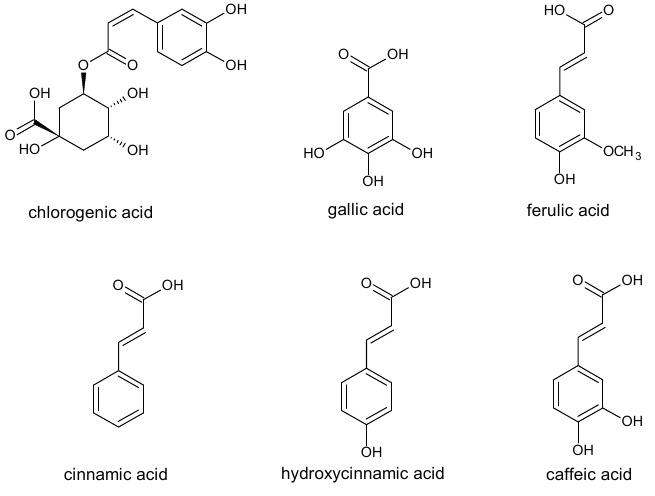
Figure 2. The structure of selected phenolic